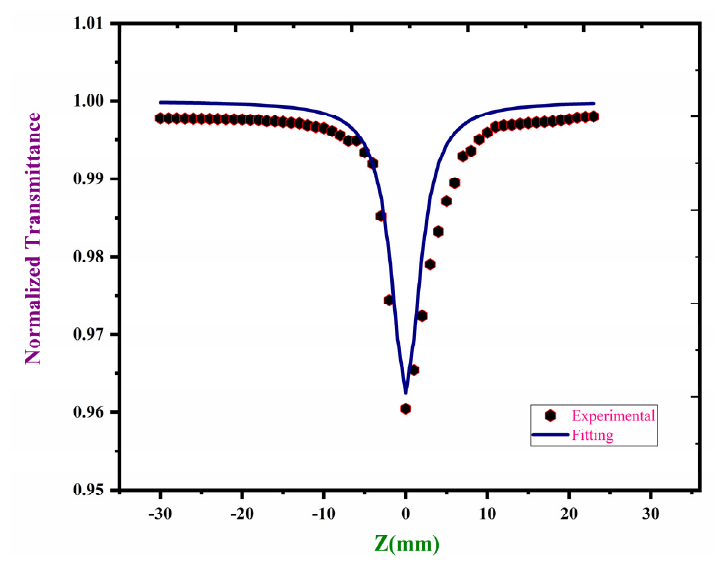
Figure 16. Open aperture Z-scan trace of MMPI.